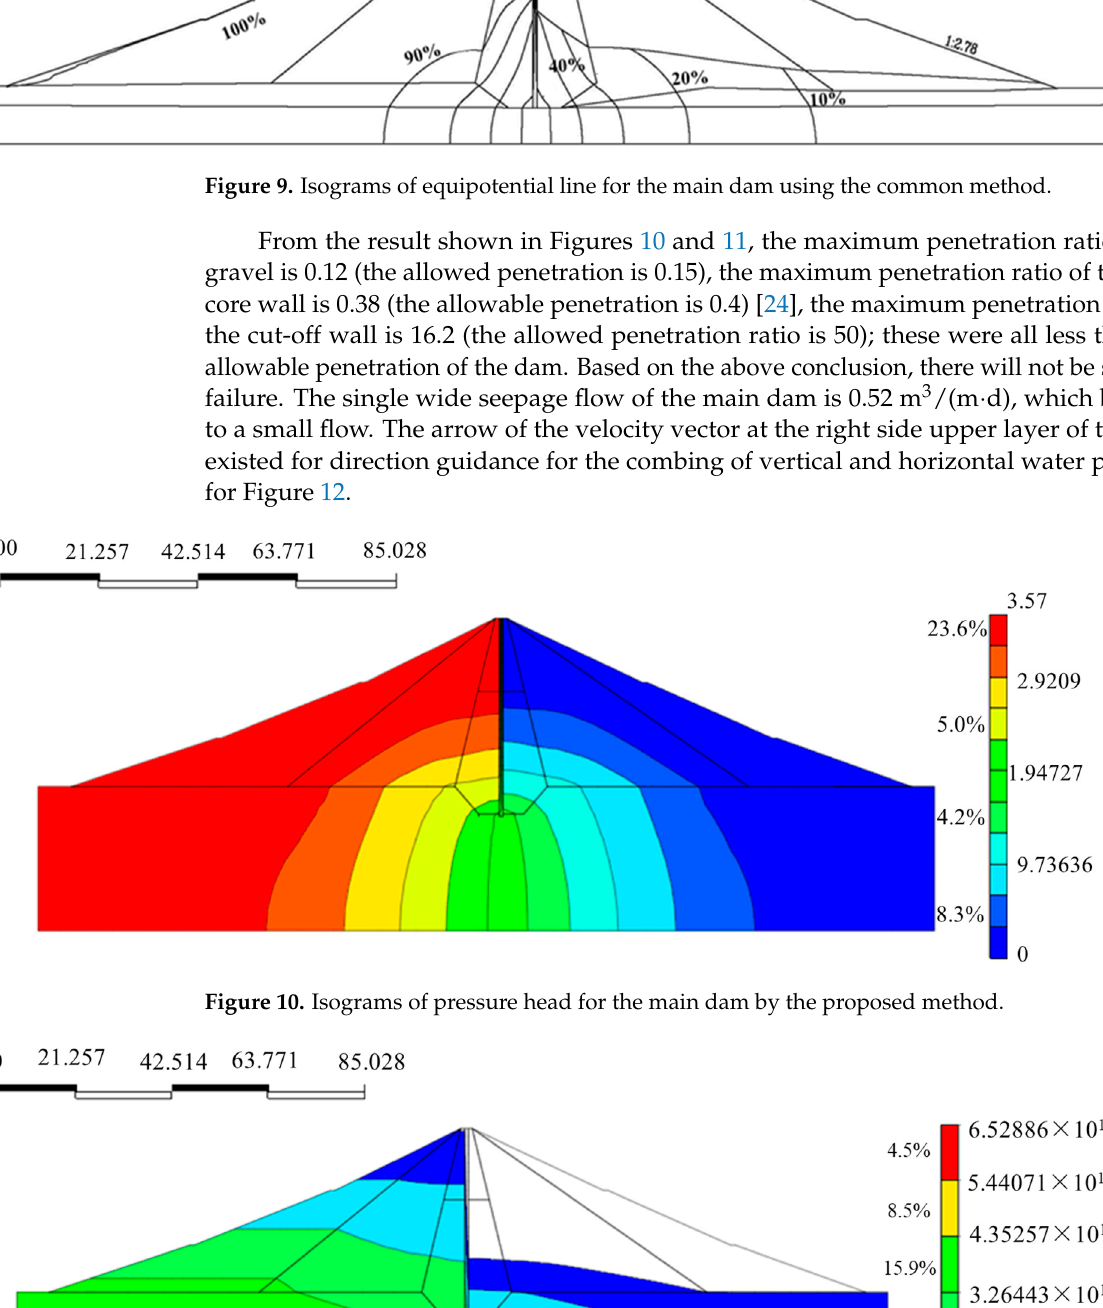
Figure 8. Isograms of pressure head for the main dam though the common method.